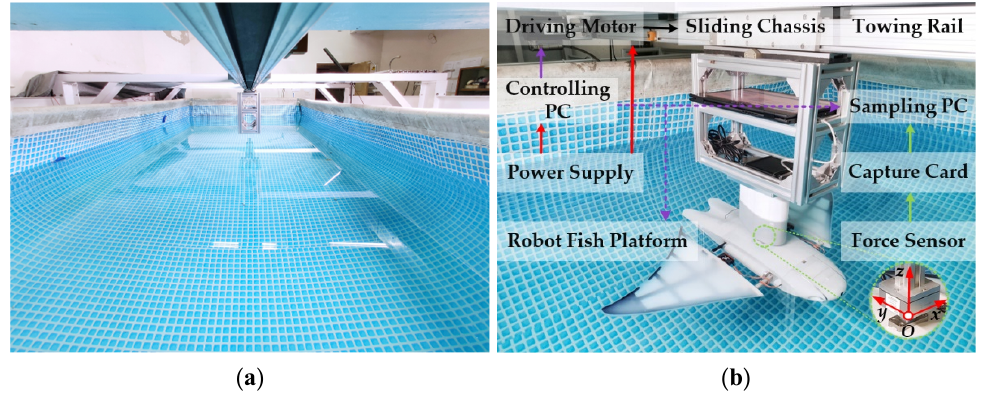
Figure 7. Environment and settings of the hydrodynamic experiments. ( a ) The experimental water pool with towing rail; ( b ) Configuration of the motion control and data collecting devices.